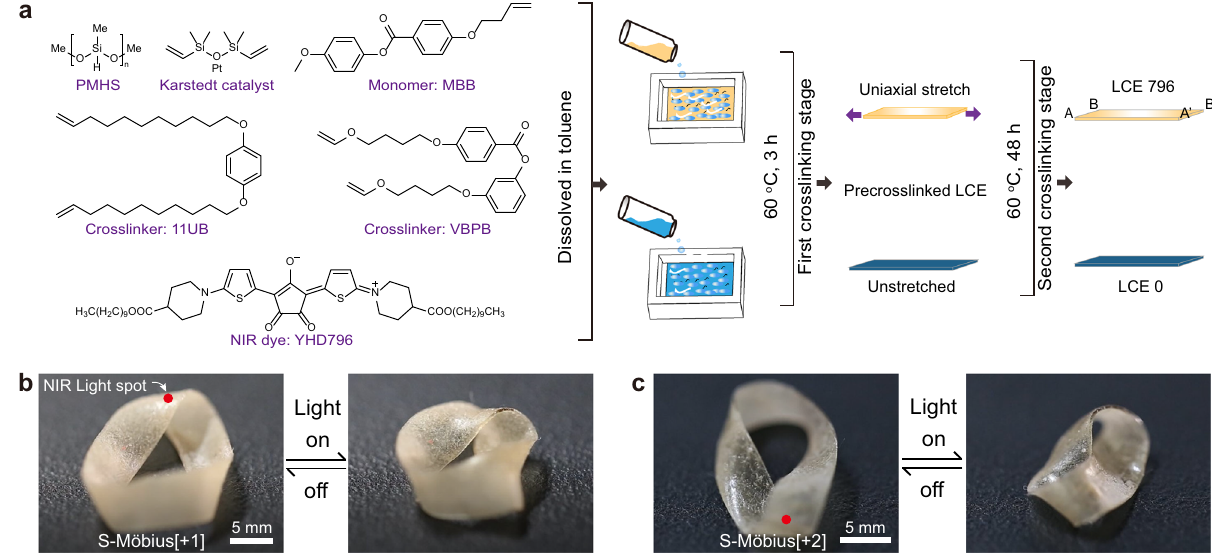
Fig. 2 Chemical composition and actuation behaviour of single-layered actuators. a Schematic illustration of the chemical components of this LCE system and the preparation procedures of LCE796 (orange part) and LCE0 (dark blue part) ribbons. Photographs of the single-layered b S-Möbius[ + 1] and c S- Möbius[ + 2] actuators upon application of a photothermal stimulus (scale bars: 5 mm). Supplementary Movie 1 shows the scenario in